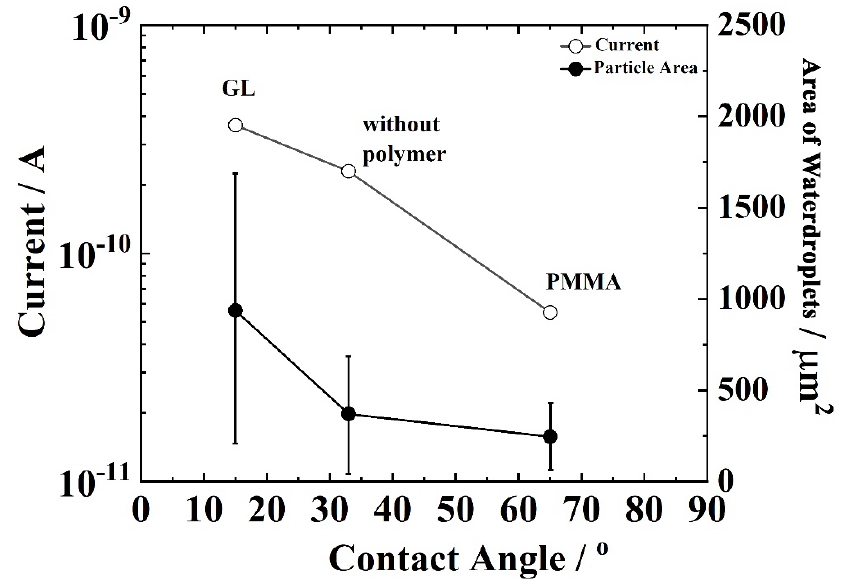
Figure 7. The output current and area of water droplets attached onto the sensor without polymer coating and coated with PMMA and GL as a function of contact angle between water droplets and the sensor surface area.